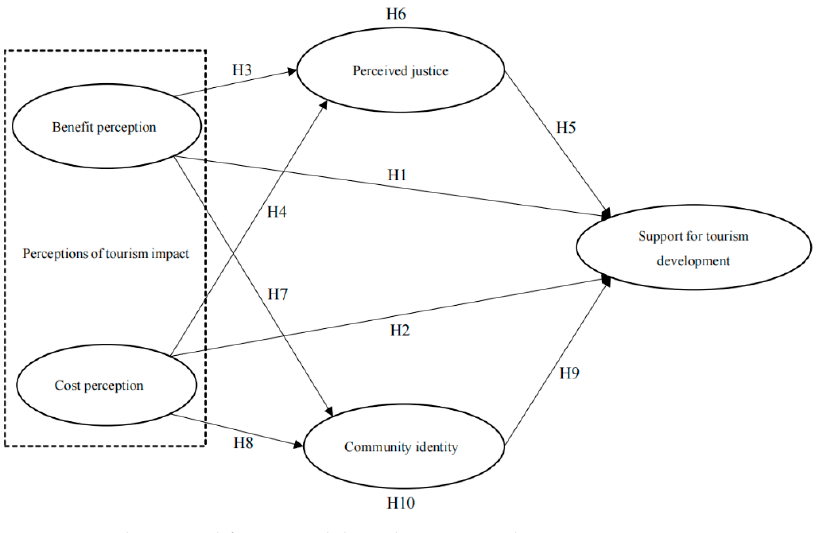
Figure 1. A theoretical framework based on SET and CAC.